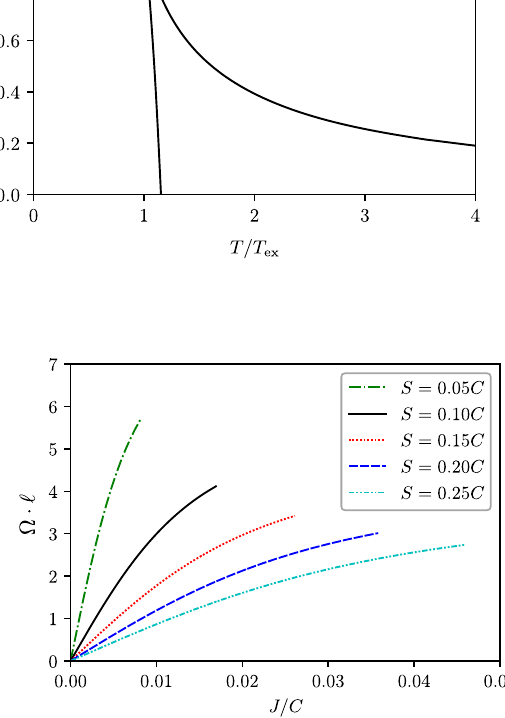
Using Eqs.(24) and (25), we present the T − S and μ − T curves in Fig.3. Besides the non-equilibrium transitions from the unstable small black hole state to the stable large black casediscussedabove,thereisalsoaHawking–Pagetransition